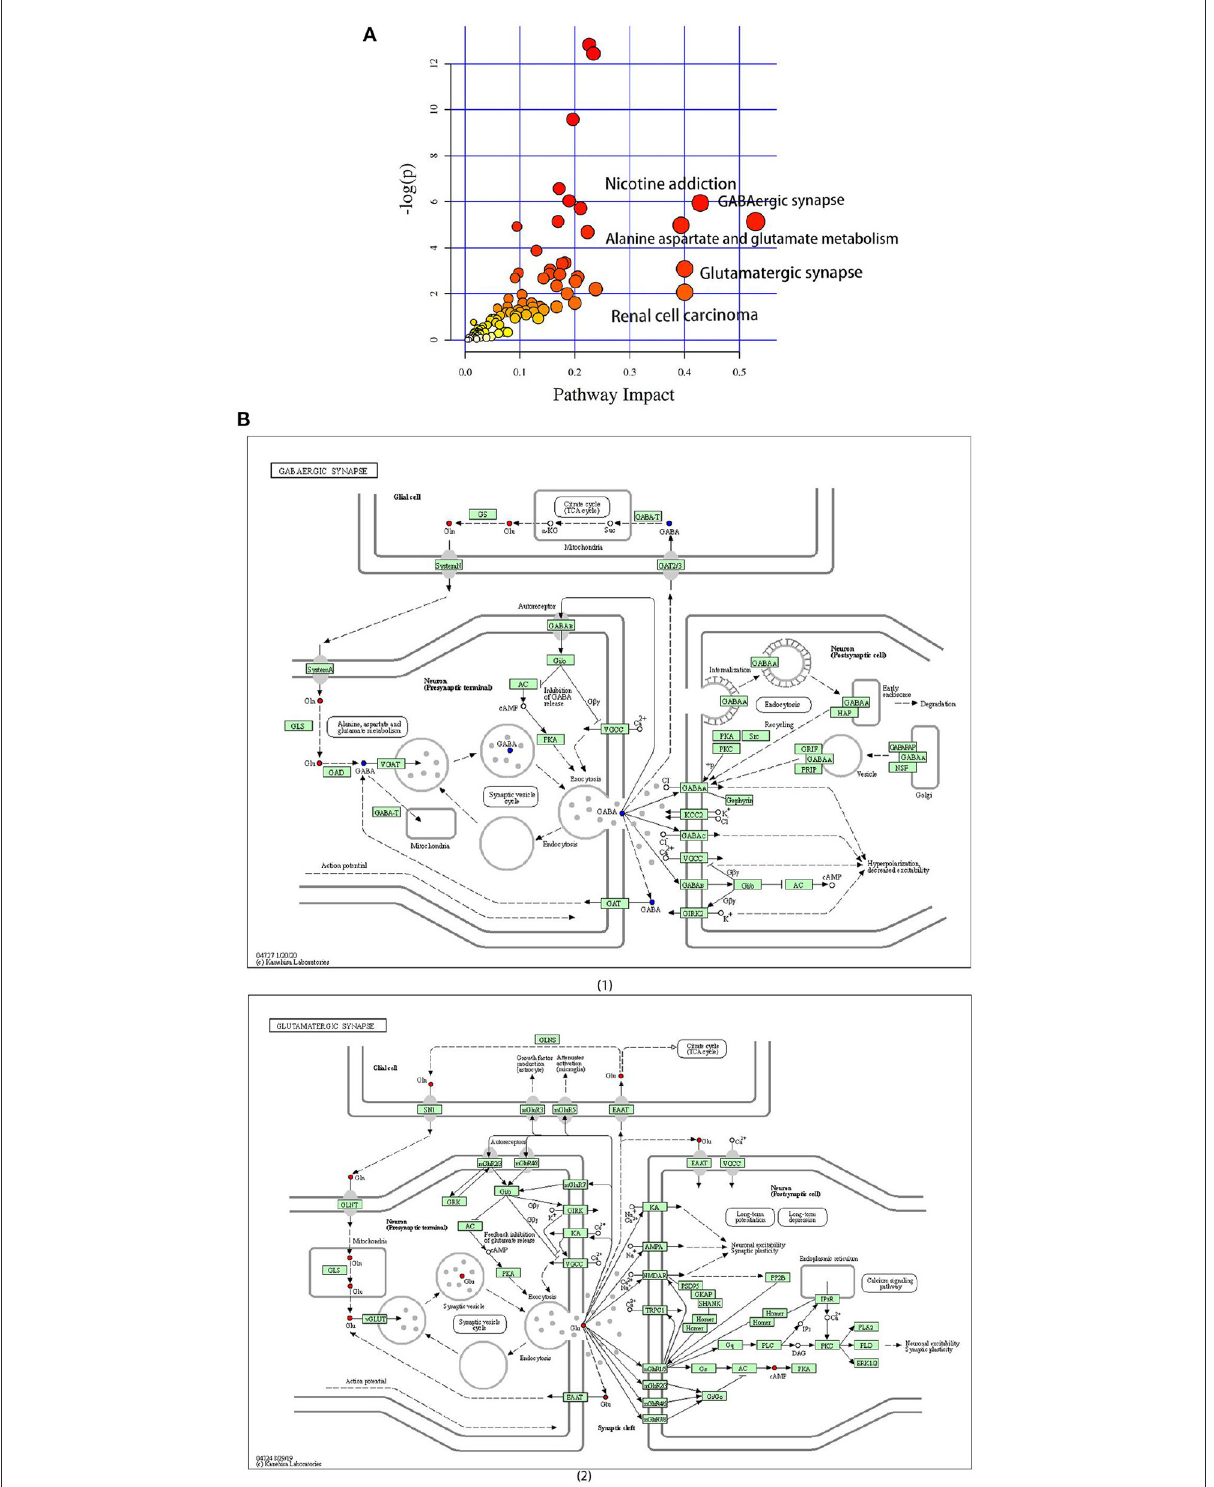
FIGURE5 The significantly different metabolites enriched KEGG pathways analysis. (A) Pathways of differential metabolites, the size and color are based on the p -value and impact value, small p -value and big pathway impact value indicate that the pathway is greatly influenced. (B) (1) Overall perspective of GABAergic synapse pathway metabolism map; (2) Overall perspective of Glutamatergic synapse pathway metabolism map. In the overall perspective of pathway map, red represents increased and blue represents